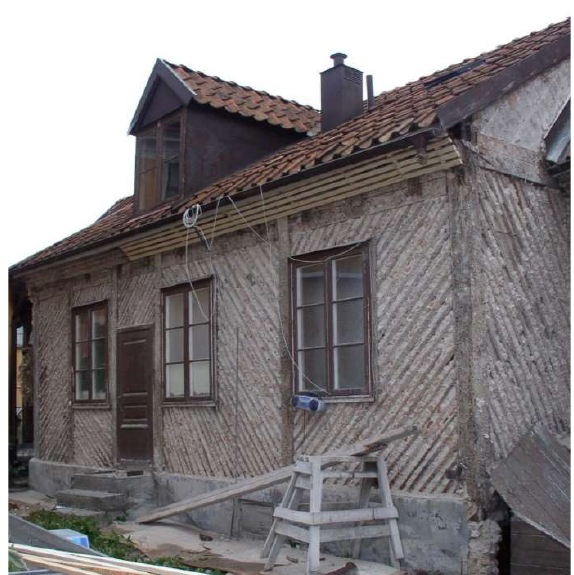
Figure 1. Exposed render on a post-and-plank house in Visby, under renovation and being re-rendered in 2003. The wooden slats were preserved, as well as the inner layer of lime mortar.